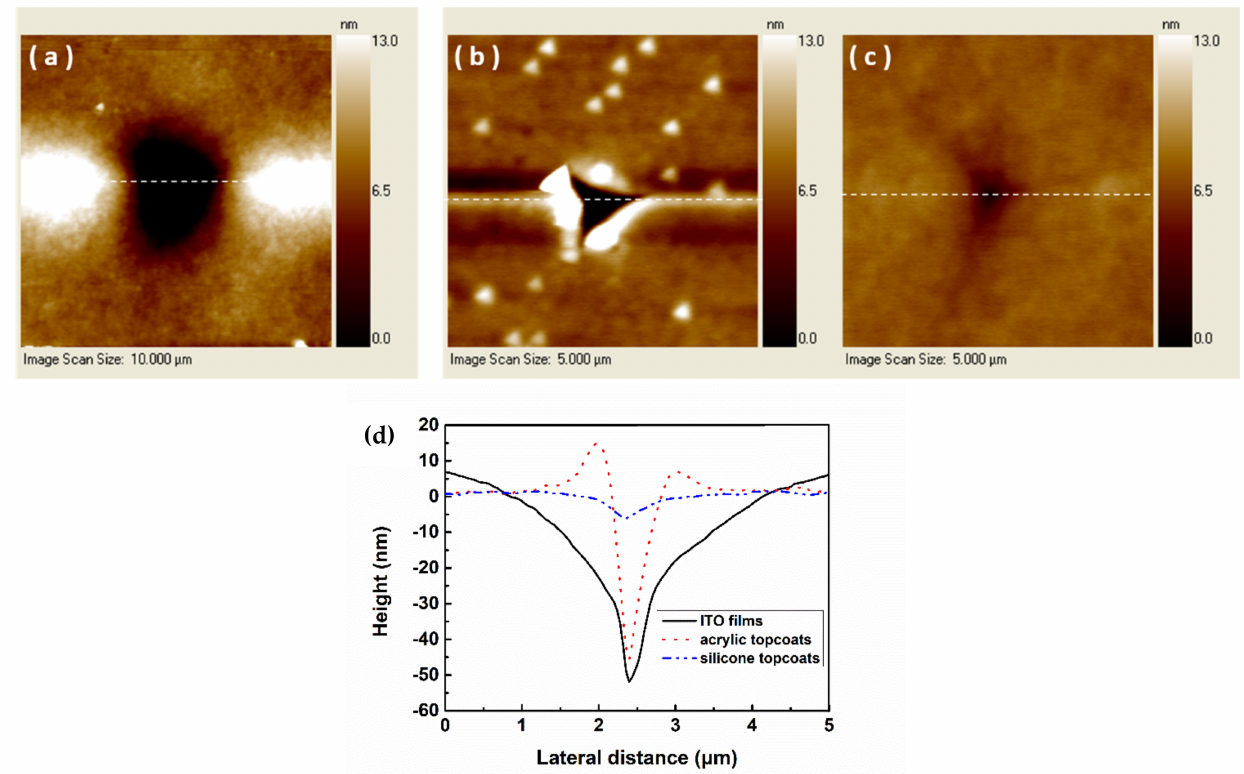
Figure 4. Surface images of ( a ) uncovered ITO films; ITO films covered by acrylic–based ( b ) and silicone ( c ) topcoats after indentation under 2000 µ N, 200 µ N and 2000 µ N, respectively and ( d ) height profiles along the lines marked on the